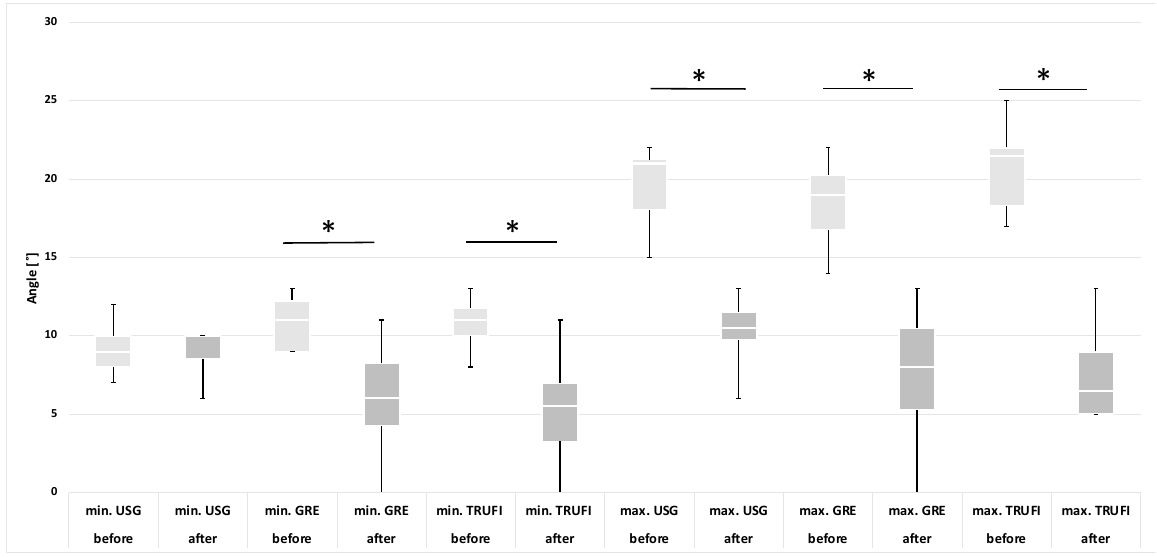
Figure 4. The minimum and maximum values of the glottic angles in the group of paralyzed vocal folds after surgery in relation to the preoperative examination with the use of US and MRI sequences (GRE and TRUFI). * p < 0.05.